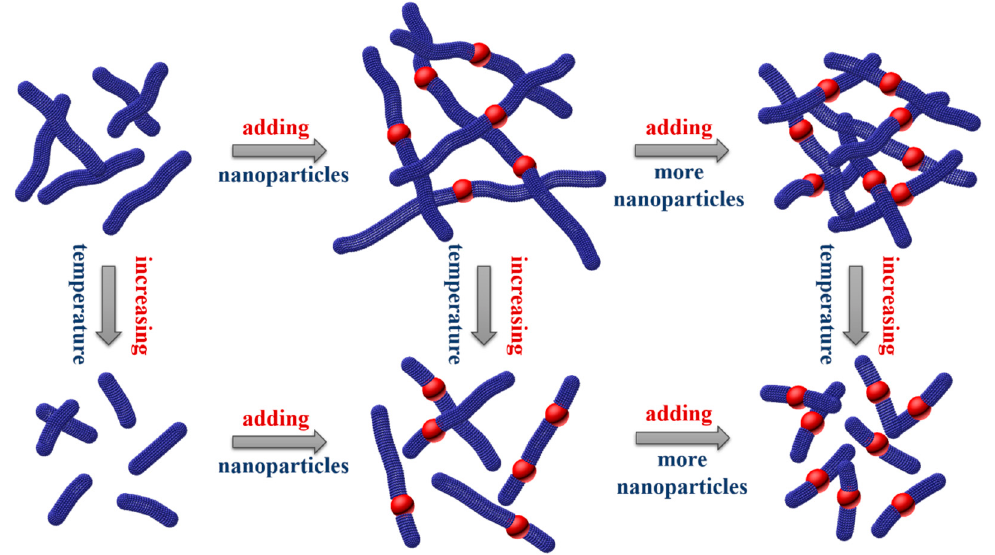
Figure 7. Illustration of the proposed mechanisms of micelle-particle junctions and effects of silica concentration and temperature on wormlike